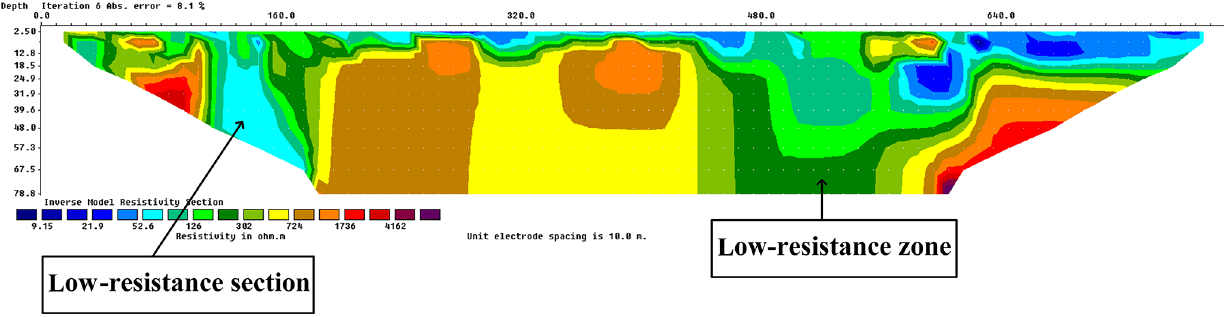
version, increasing the power of the transmitting board, and adding a GPS